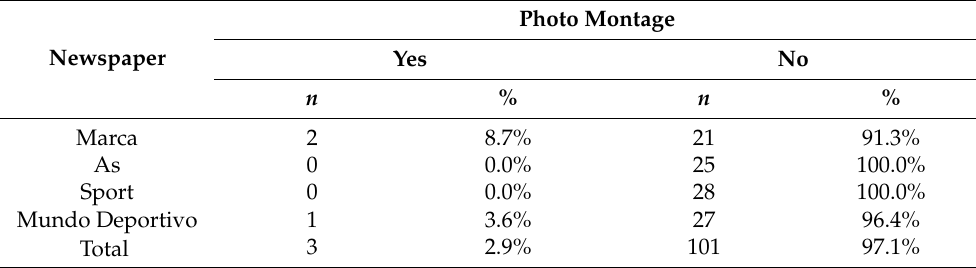
Table 6. Use of photo montage depending upon newspaper. Compiled by author.